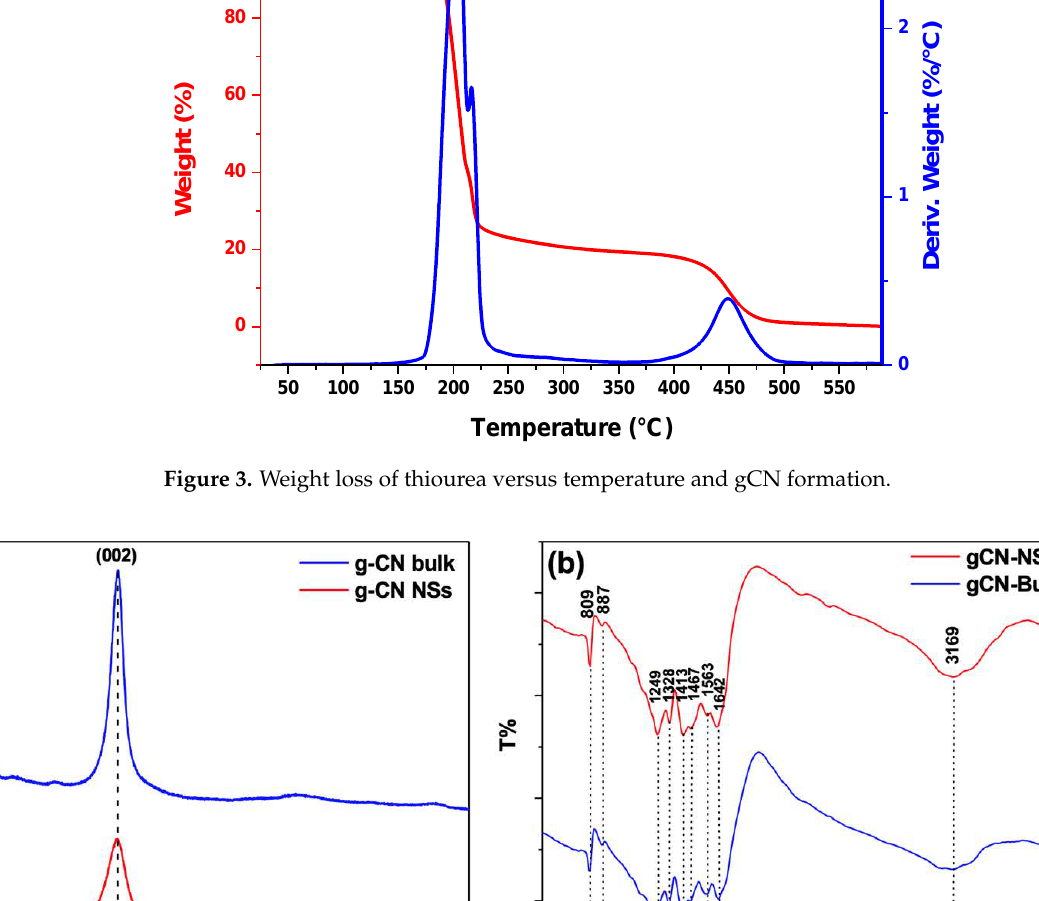
Figure 4. ( a ) X-ray diffraction diagram and ( b ) FTIR spectra of gCN bulk and nanosheets.